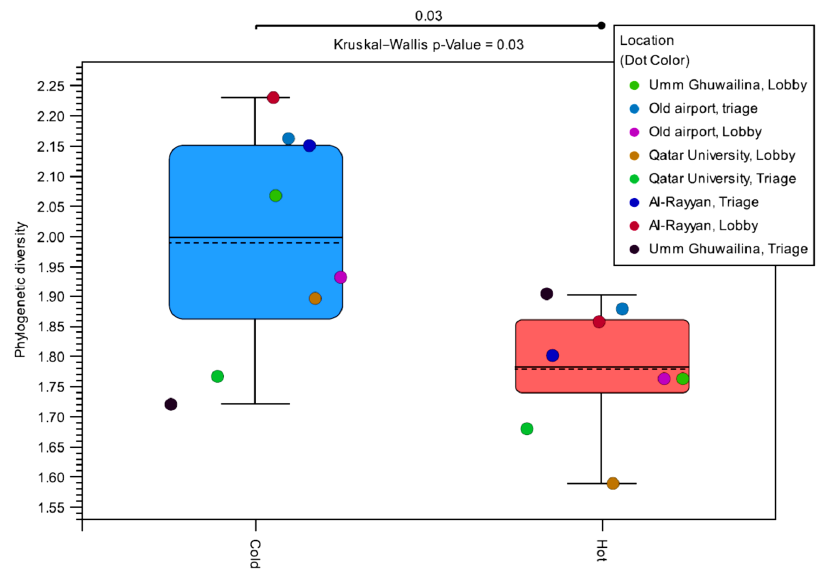
Figure 8. Distribution of the alpha diversities by season. Alpha diversity represents the diversity within each sample through the number of bacterial species in each sample weighted by their abundance. Each pair of points sharing the same color was obtained in different seasons from the same location.